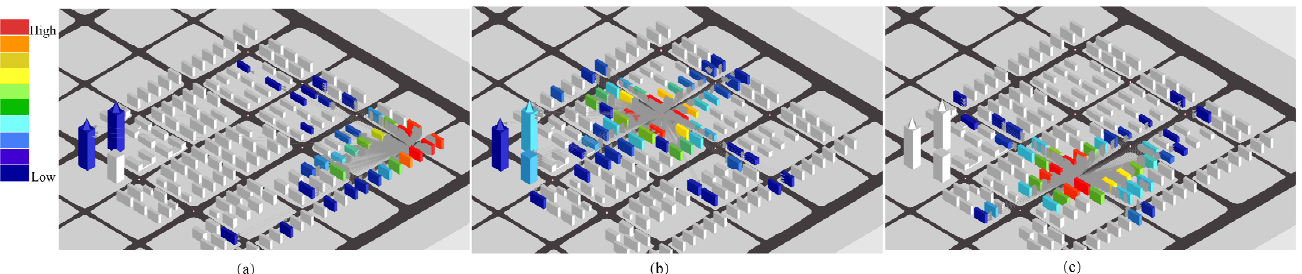
Figure 5. Measuring the visibility of landmarks using 3D isovists. ( a ) V 1 , ( b ) V 7 , ( c ) V 10 . Table 1. Visible area of landmarks from each viewpoint.